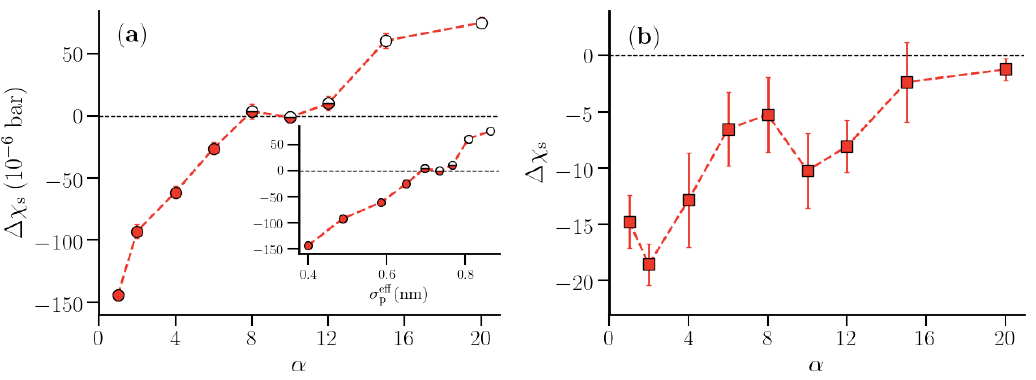
Figure 8. ∆ χ s profiles for the first ( a ) and second ( b ) polymer hydration shell for various values of the repulsive interaction parameter α . The inset in ( a ) shows ∆ χ s as a function of σ eff p . In ( a ), the data points are grouped based on their variation with α (see text). The error bars are calculated over four distinct windows in the production trajectory. The lines are guide to the